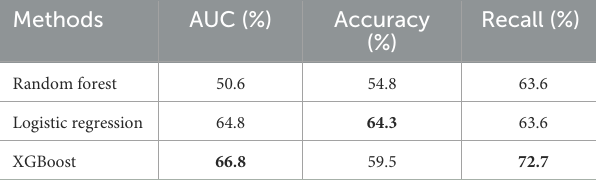
TABLE 4 A quantitative comparison of the effectiveness of different machine learning algorithms based on clinical